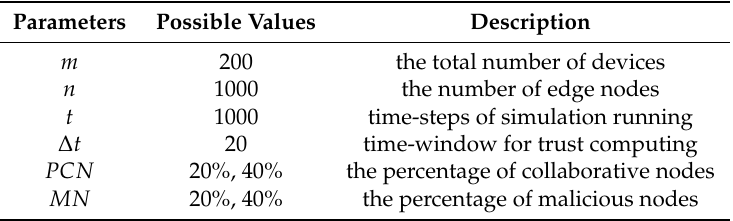
Table 1. Parameters and their possible